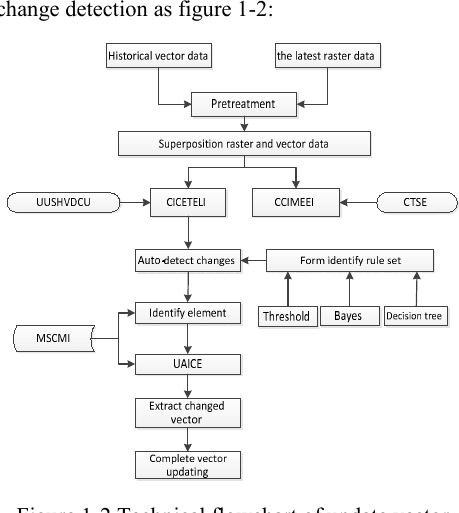
Figure 1-2 Technical flowchart of update